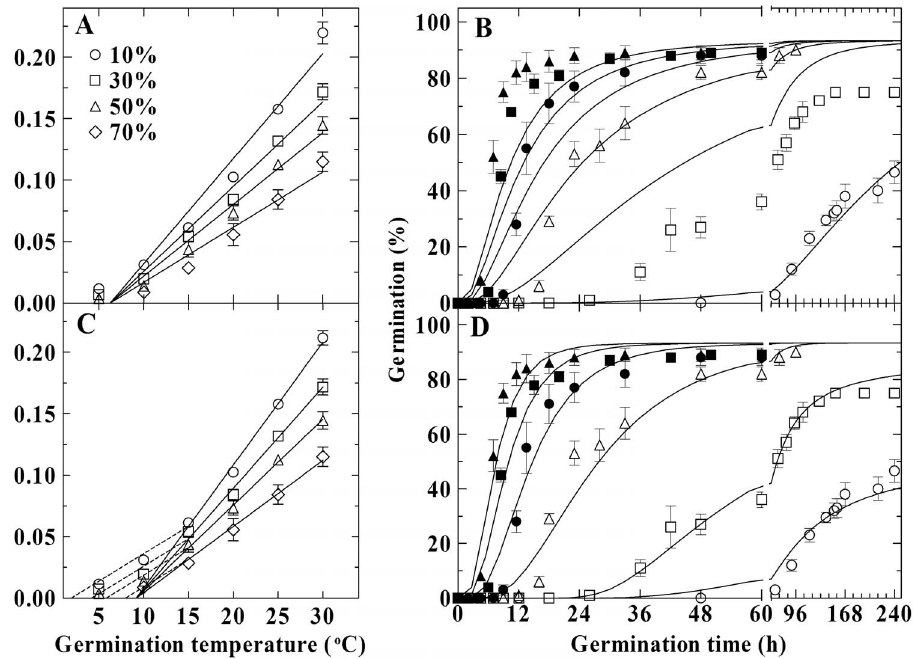
Figure 1. Comparison between the thermal time (TT) and the modified thermal time (MTT) models in describing germination of control seeds at various temperatures. TT model: germination rates were regressed with linear lines constrained to converge upon a common base temperature (A), and time courses of germination at 5 ( # ), 10 ( % ), 15 ( g ), 20 ( parameters in Table 1 (B). MTT models: germination rates were regressed with lines constrained so they shared the same slope at temperature range of 5–10 u C and to converge upon a common base temperature at 15–30 u C (C), and the time course of germination at 5–10 u C and 15–30 u C were fit to equations (13) and (2) according to parameters in Table 1, respectively (D). doi:10.1371/journal.pone.0062868.g001 fit at 5 u C ( R 2 = 0.66), the MLT model accurately described the effect of storage time on seed germination ( R 2 from 0.81–0.91, Table 2). When time courses of germination at a given temperature after storage were normalized to the time course of control seeds using a factor of (1- p / p max ( g )) t g ( p ) (equation (5)), germination data at each germination temperature were well predicted by a common curve (Figure 2).